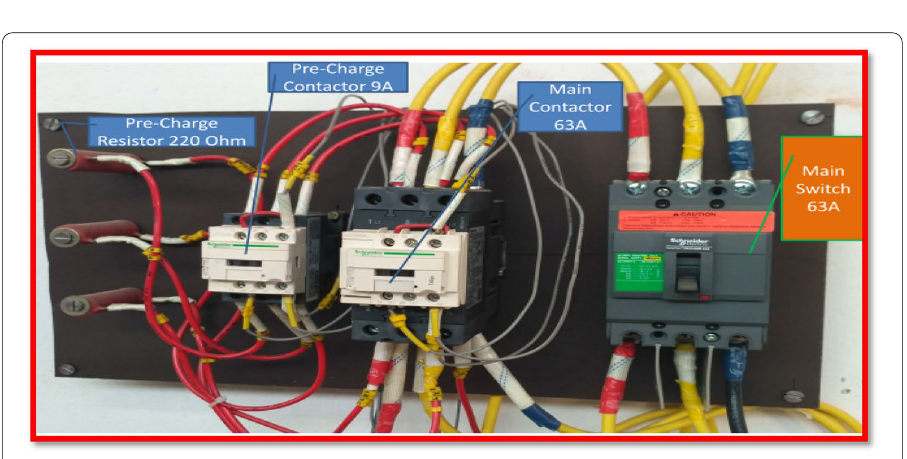
Fig. 5 Hardware model of pre-charge